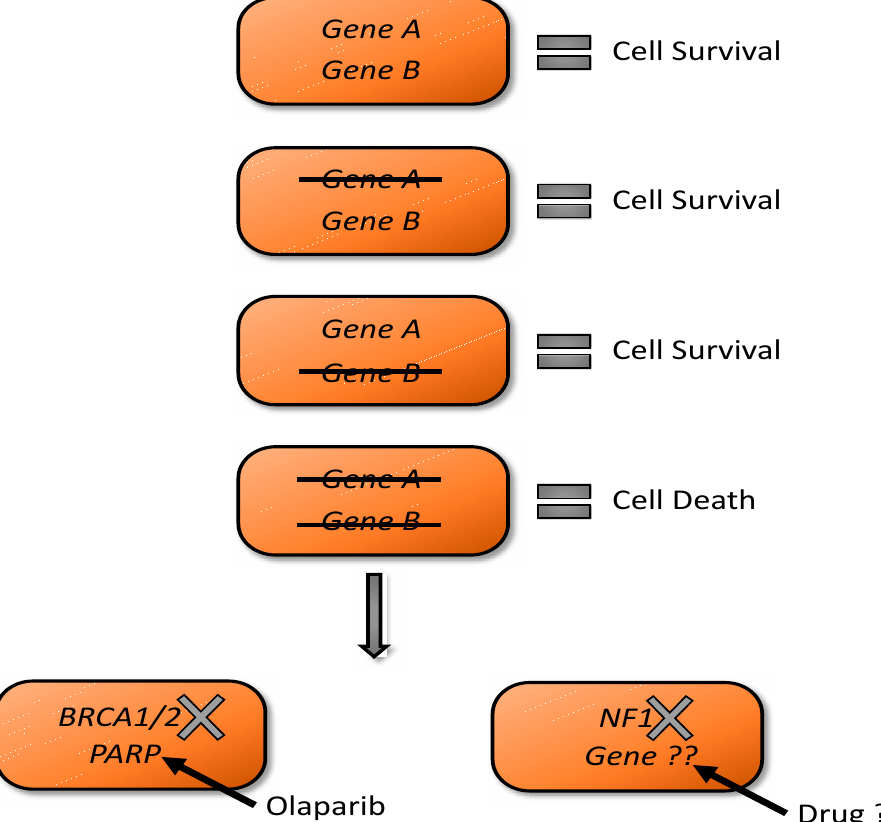
Figure 1. Synthetic lethality if the genetic incompatibility of the loss of two independent gene products results in cell death. Whereas a hypothetical cell can survive with either loss of Gene A or Gene B , it cannot live with loss of both simultaneously. A prime example of this being exploited therapeutically is in BRCA1 / 2 mutated cancers and their sensitivity to PARI inhibitors such as olaprarib. Similarly, loss of NF1 could render human Schwann cells sensitive to pharmacologic intervention with novel agents.